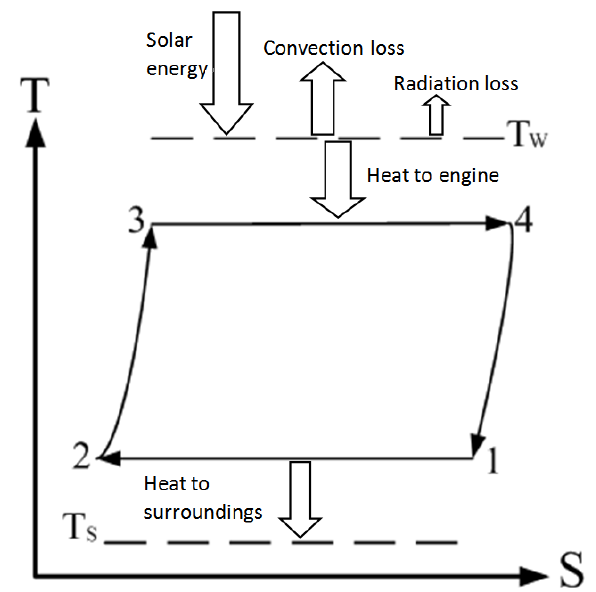
Figure 1. Heat flows involved in a Stirling engine with solar